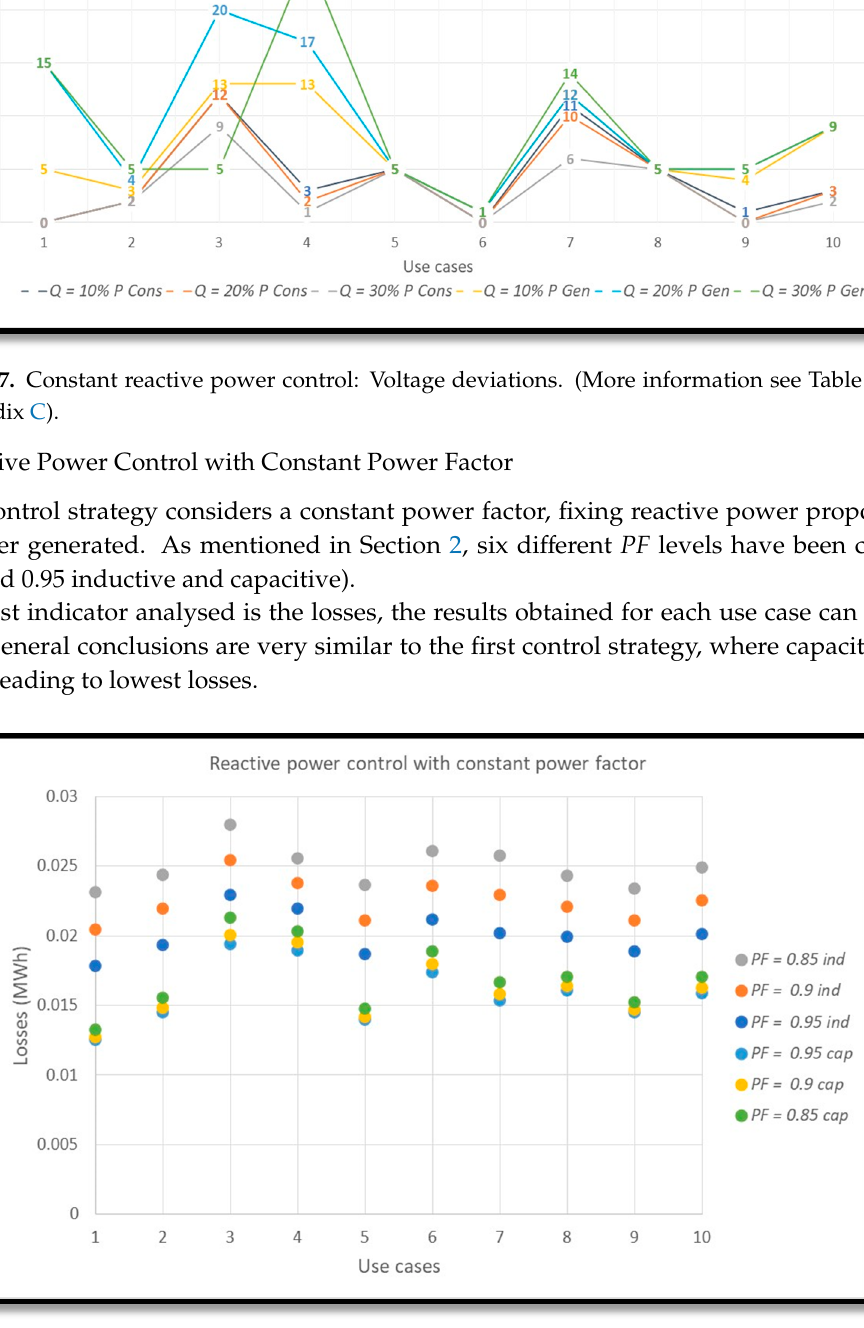
Figure 8. Reactive power control with constant power factor: Losses (More information see Table A5 in Appendix C).